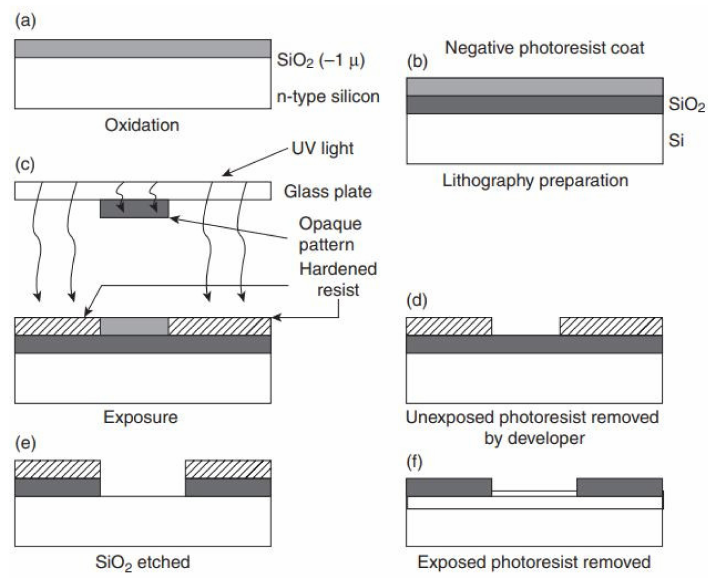
Figure 4. Sequential processes in transferring a pattern/design onto the substrate surface [114]. (Adapted with permission from Ref. [114]. Copyright 2013